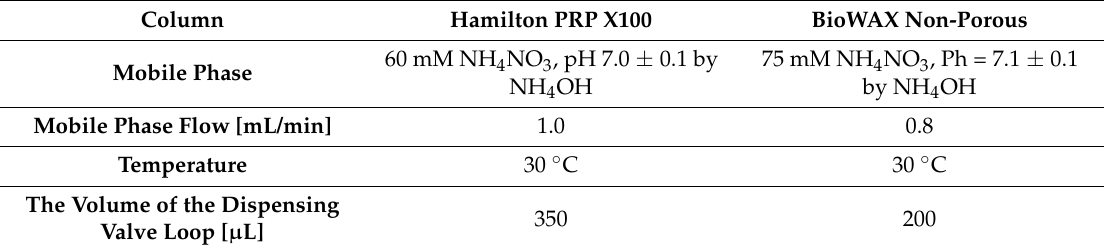
Table 5. Basic Liquid Chromatogrpahy parameters for speciation analysis.